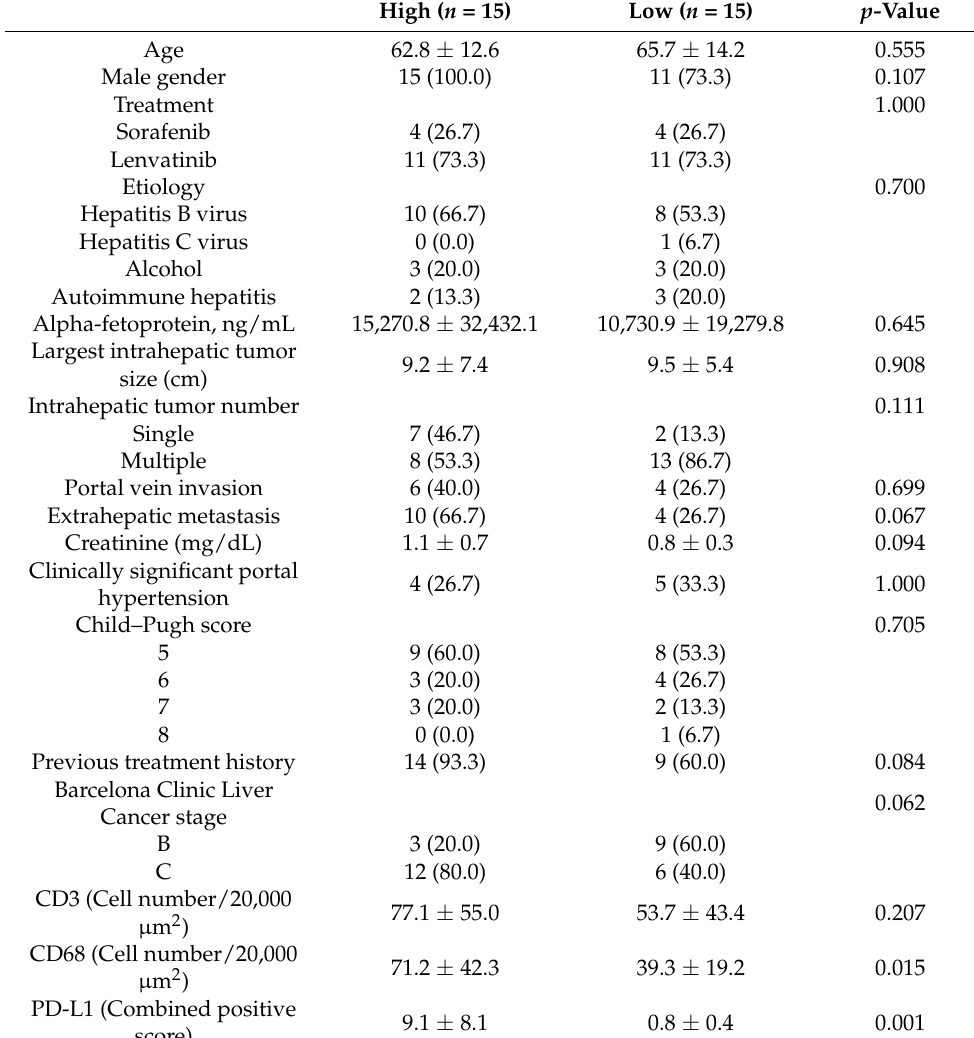
Table 2. Comparison of baseline characteristics between the high and low PD-L1